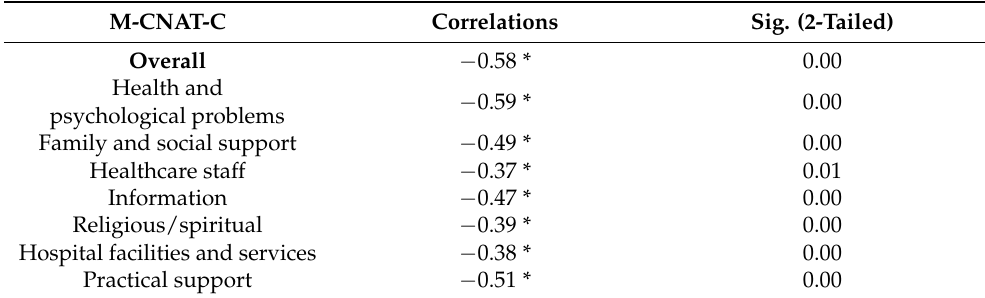
Table 2. Correlations between total M-CarGOQoL and M-CNAT-C domain